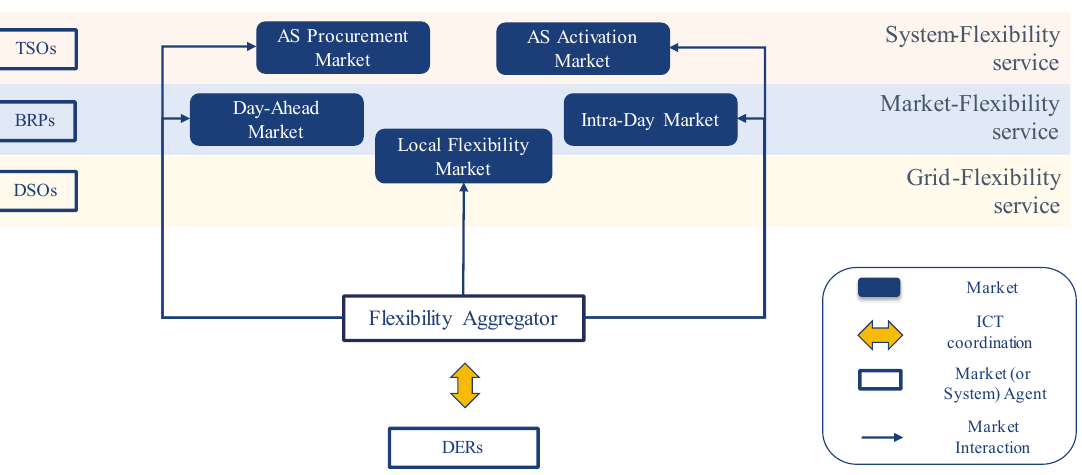
Figure 6. Third stage: Full exploitation of the DERs’ flexibility is achieved with access to wholesale short-term markets and to the local flexibility market (LFM). The latter is placed in the market service layer and in the grid service